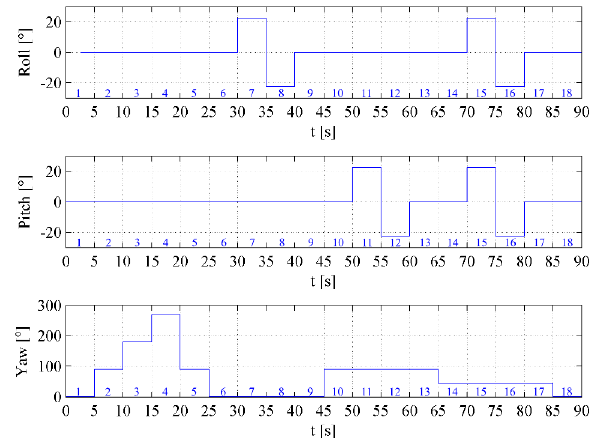
Figure 9. Sequence of desired orientation represented using Euler angles.